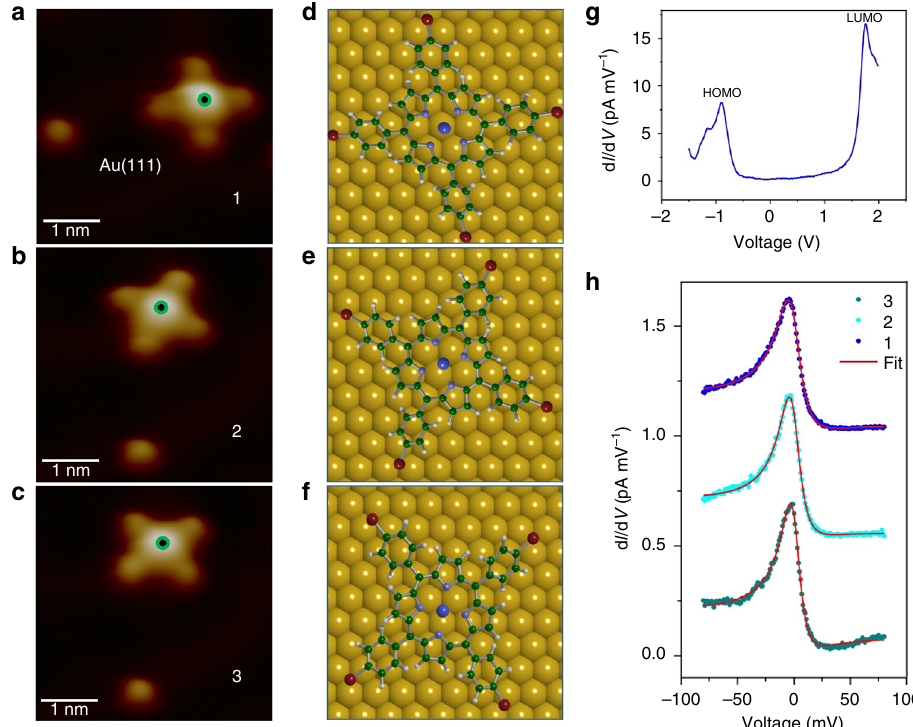
Fig. 2 Properties of TBrPP-Co/Au(111). a – c Three orientations of TBrPP-Co on Au(111) induced by STM manipulation labelled as 1, 2 and 3, respectively. The protrusion next to the molecule is used as a landmark (4.2 × 4.2 nm 2 , I t = 1 × 10 − 10 A, V t = − 1.0 V). Green dots indicate where the Kondo effect is measured. d – f DFT adsorption structures of TBrPP-Co corresponding to 1, 2 and 3, ( a – c ), respectively. g A d I /d V – V spectroscopic data of TBrPP-Co on Au(111) showing HOMO – LUMO orbitals (tip set-point: I 0 = 5 × 10 − 11 A, V 0 = − 1.0 V). h High-resolution d I /d V spectra of TBrPP-Co/Au(111) corresponding to three adsorption geometries, 1, 2 and 3, revealing a Kondo resonance ( q = 0.37, 0.36 and 0.40 for 1, 2 and 3, respectively. Tip set-point: I 0 = 1.0 × 10 − 10 A, V 0 = − 0.1 V. Spectra are vertically offset by 0.5 pA/mV for